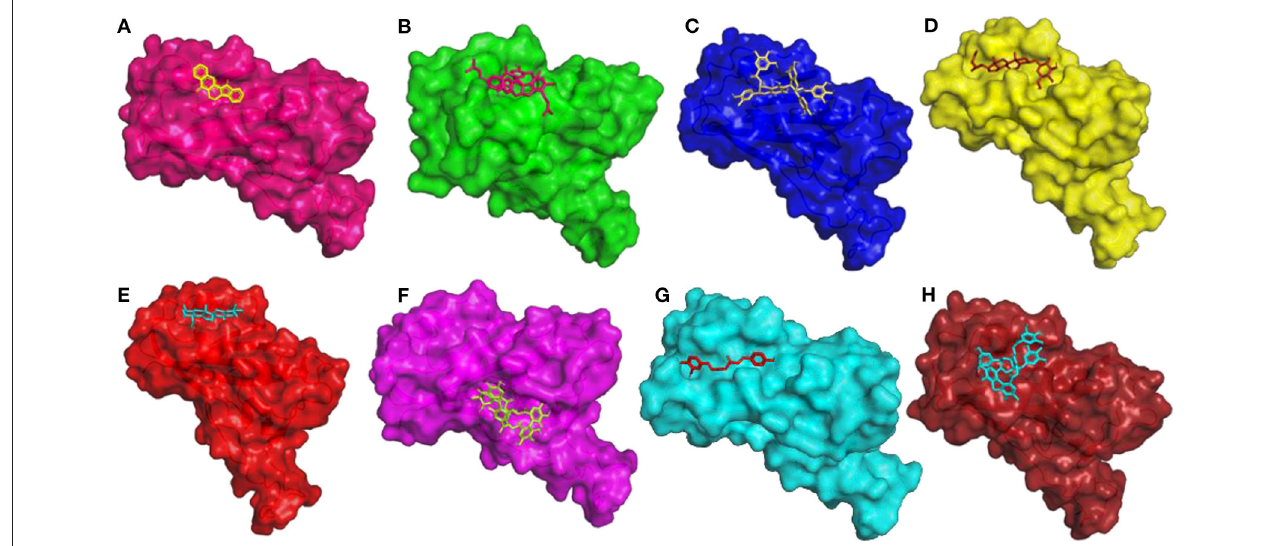
FIGURE 6 | 3D diagram of RBD of Spike Glycoprotein in complex with (A) Rutaecarpine, (B) Licoagrodin, (C) 3-O-Galloylepicatechin-(4Beta-6)-Epicatechin-3-O- Gallate, (D) Daucosterol, (E) Caryophyllene, (F) Geraniin, (G) O-Demethyldemethoxycurcumin, and (H) Tellimagrandin-II.